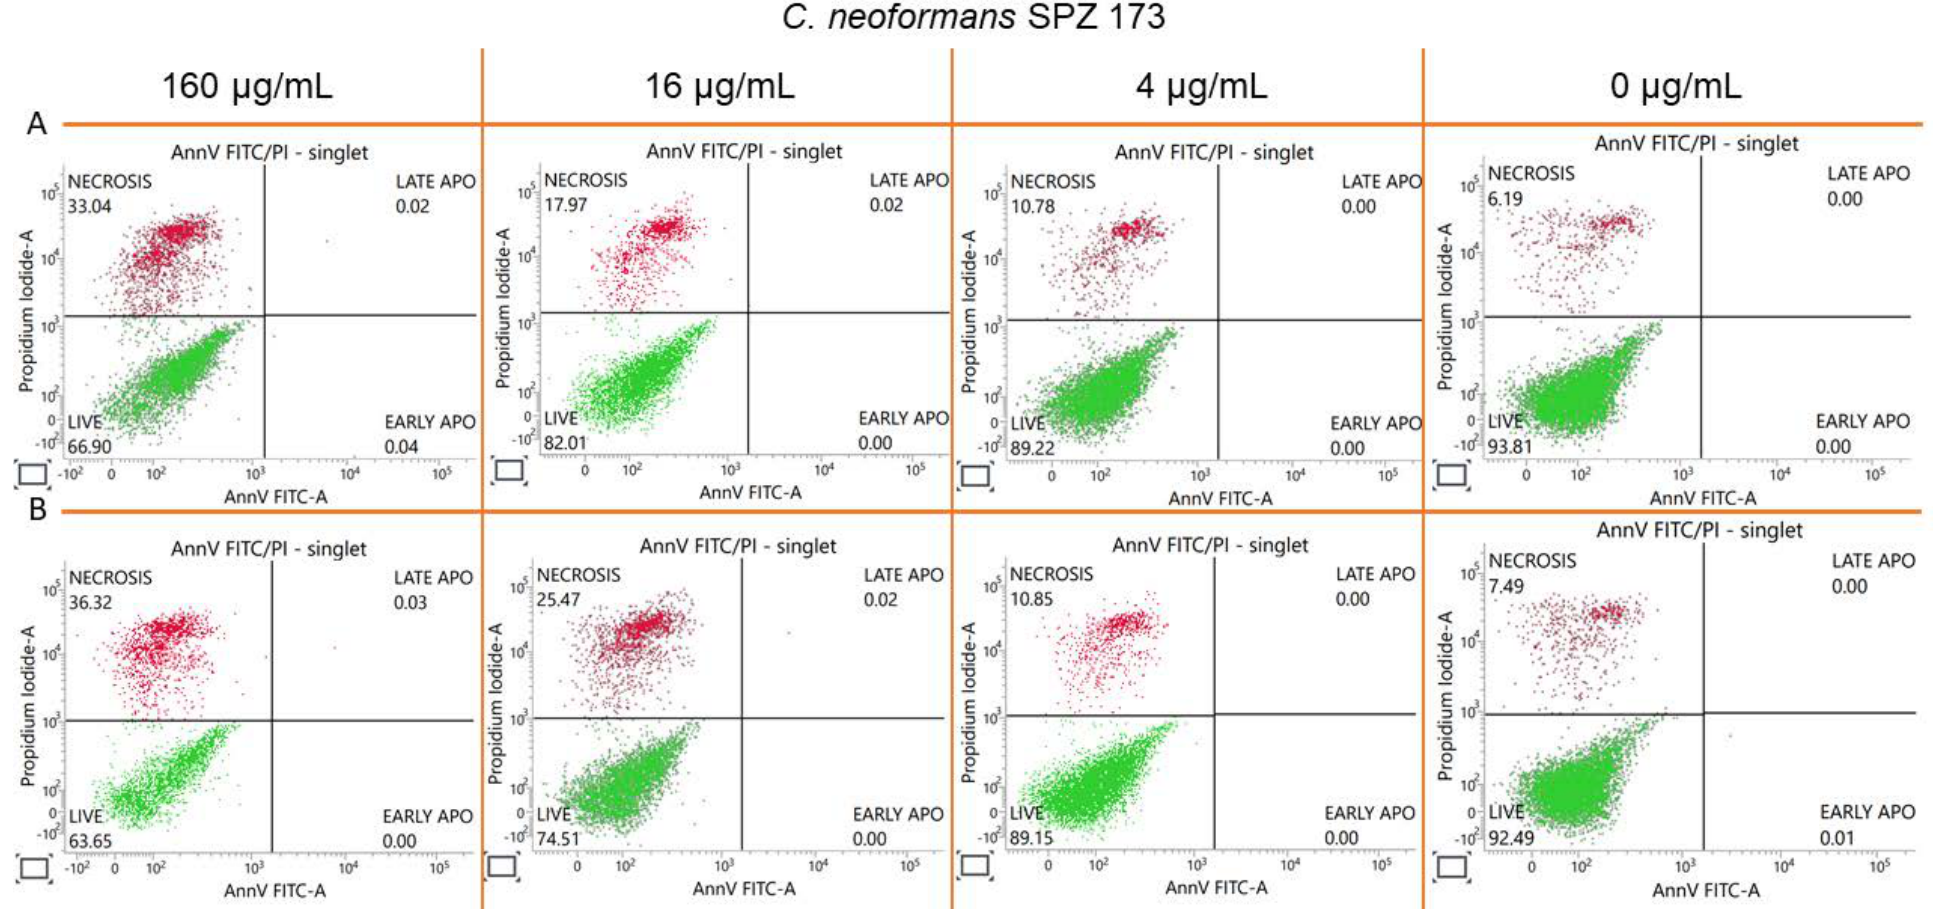
Figure 4. Flow cytometric analysis of the cell death type of C. neoformans SPZ173 treated with 5h . Legend: ( A ) cells; ( B ) protoplasts; EARLY APO means early apoptosis; LATE 2 APO means late apoptosis. Data represent mean ± SD, n = 3.